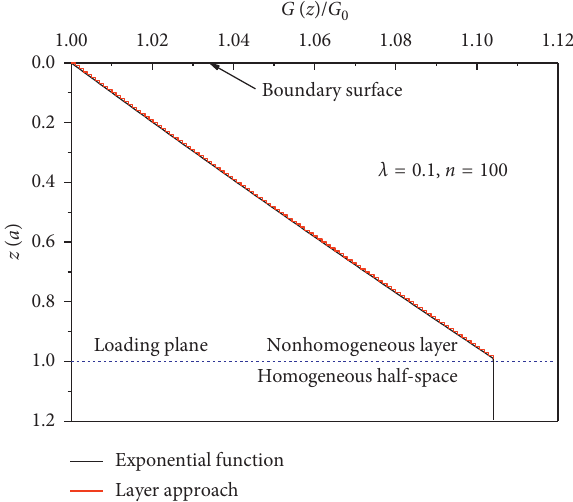
Figure 4: Approximation of the continuous depth variation of the shear modulus by a layered system of 100 piecewise homogeneous layers for λ � 0 . 1 and h / a � 1.